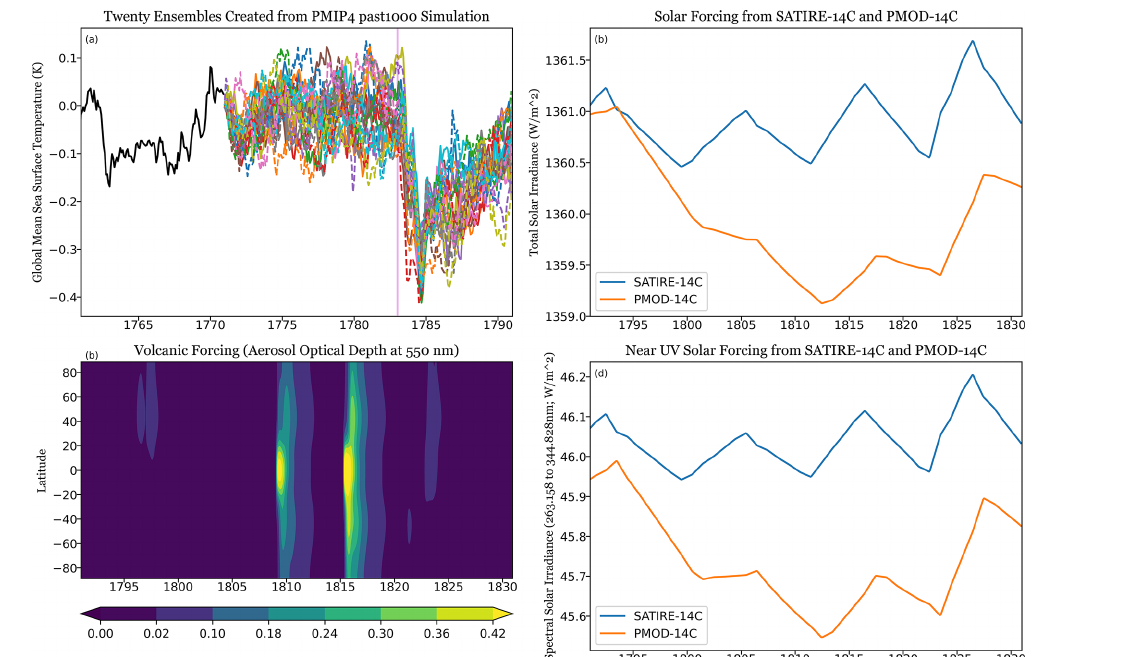
Figure 1. (a) Global mean sea surface temperature anomalies (K) of past2k simulation (black) and the perturbed 19 ensemble members. The vertical magenta line indicates the 1783 Laki eruption. (b) Total solar irradiance (Wm − 2 ) for the solar forcing of SATIRE-14C and PMOD- 14C. (c) Aerosol optical depth at 550nm (unitless) for the volcanic forcing. (d) Near UV spectral solar irradiance (263.158 to 344.828nm; Wm − 2 ) for the solar forcing of SATIRE-14C and